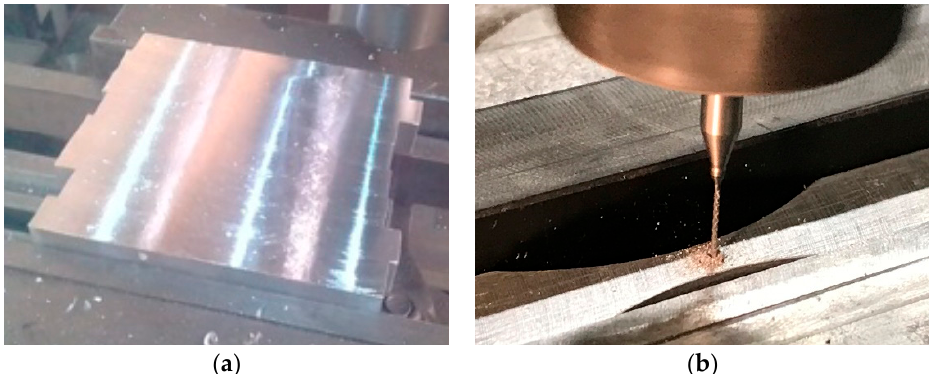
Figure 6. Specimen C—longitudinal pits.